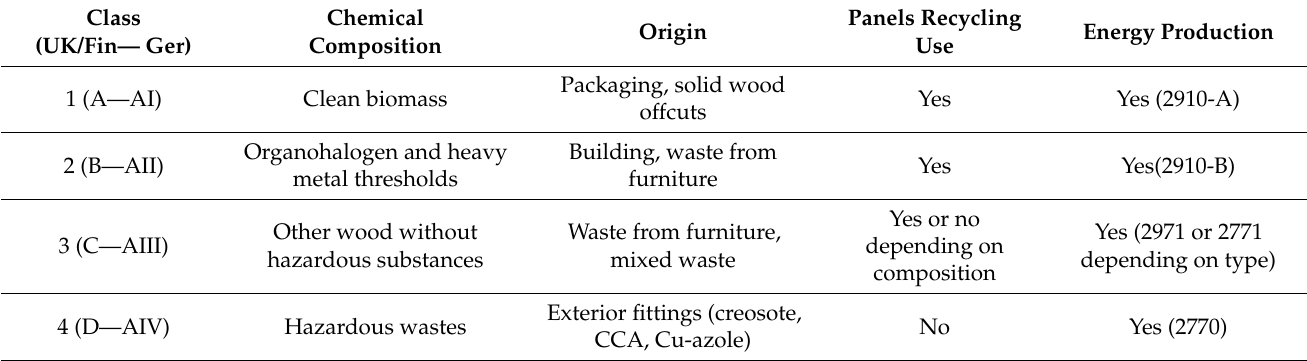
Table 3. Classification under discussion at the French level for wood waste